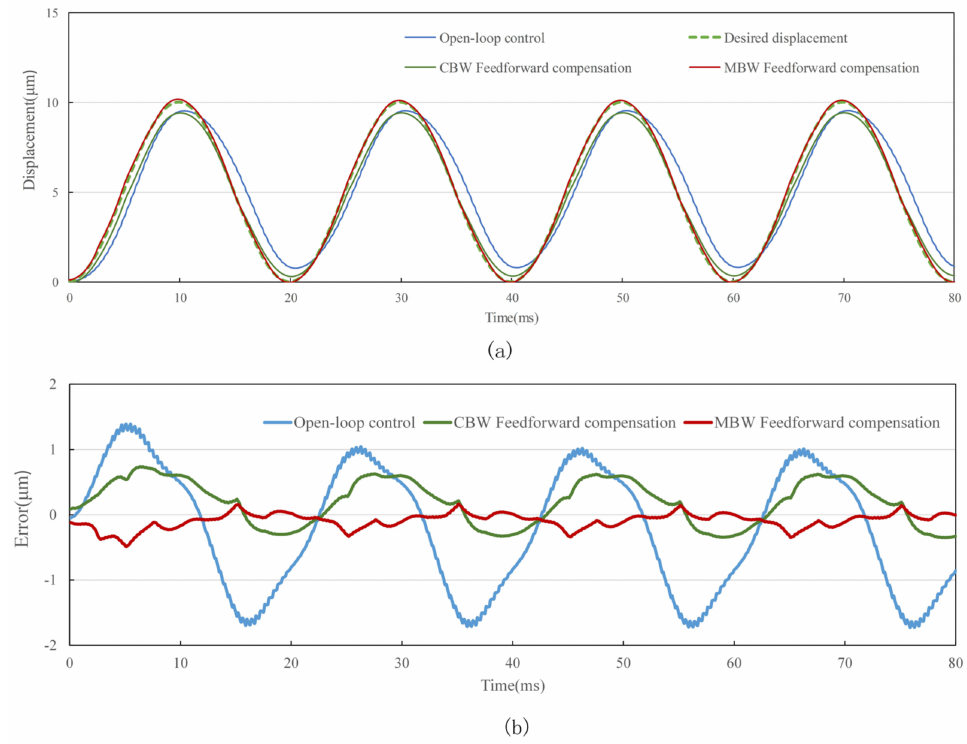
Figure 16. Standard sinusoid signal tracking performance with different control method at 50